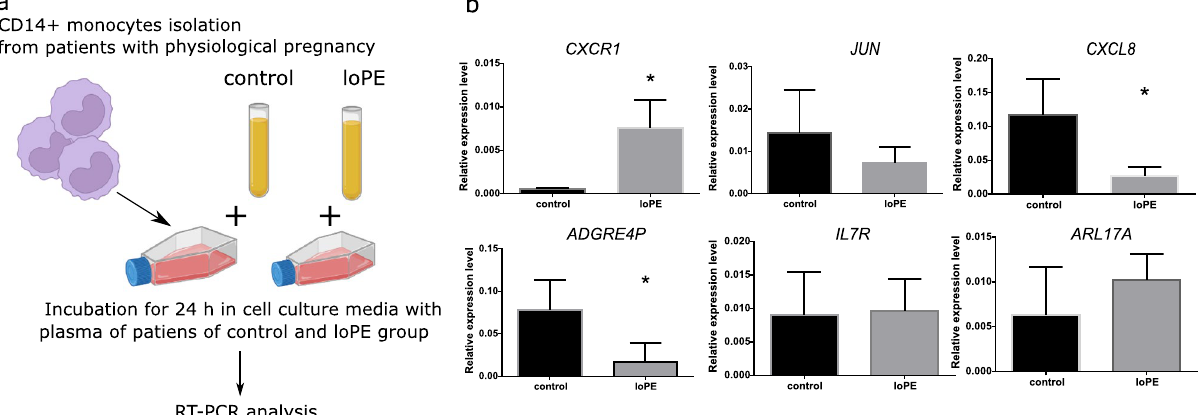
Figure 5. Effects of blood plasma (control vs loPE) on CD14++ monocytes isolated from healthy pregnant gestational age-matched donors (n = 3). A scheme of the experiment ( a ). CD14++ monocytes isolated from pregnant gestational age-matched donors were incubated in culture medium supplemented with plasma (10%) obtained from control (n = 3) or loPE (n = 3) patients for 24 h followed by RNA isolation and RT-PCR analysis ( b ). loPE late-onset PE. *p < 0.05 according to Mann–Whitney test. The data are presented as mean ±